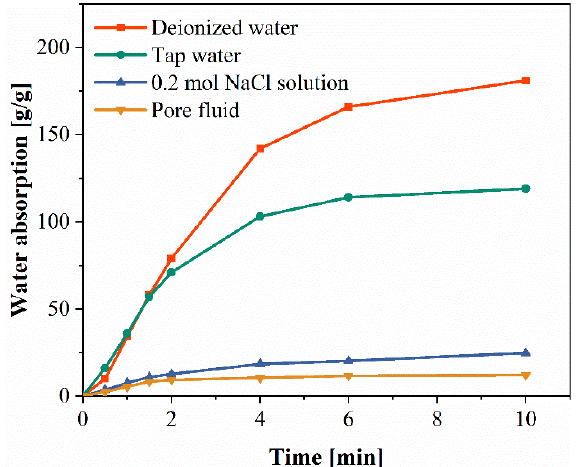
Figure 5. Water absorption of SAP in different liquid environments.